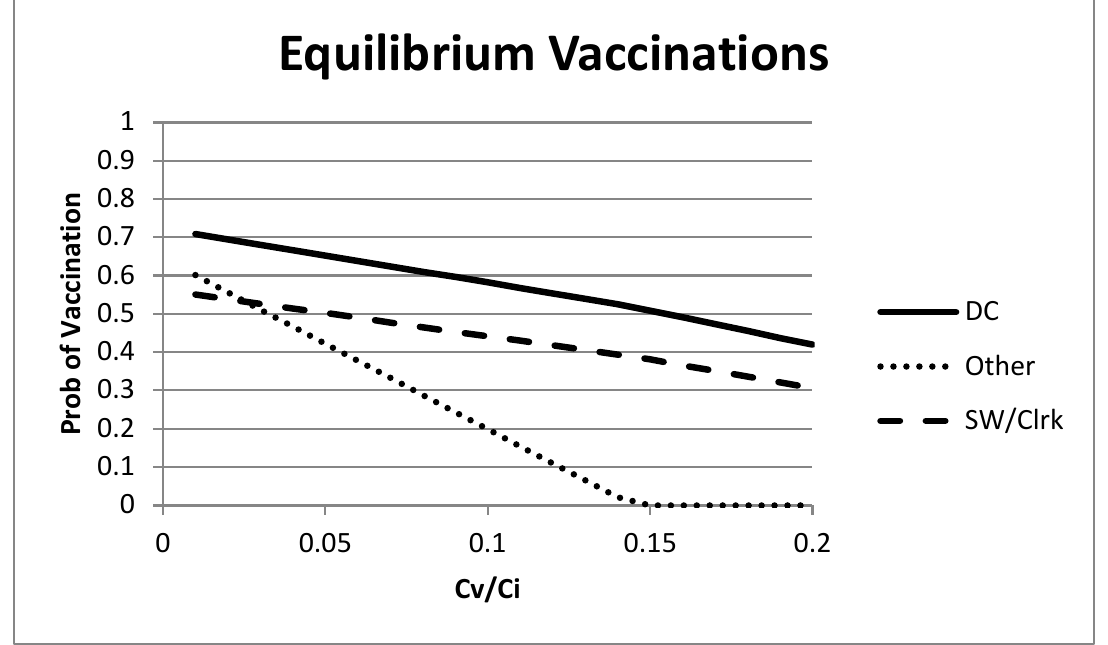
Figure 2. Mixed strategy equilibrium vaccination choices as a function of the ratio of vaccination and infection